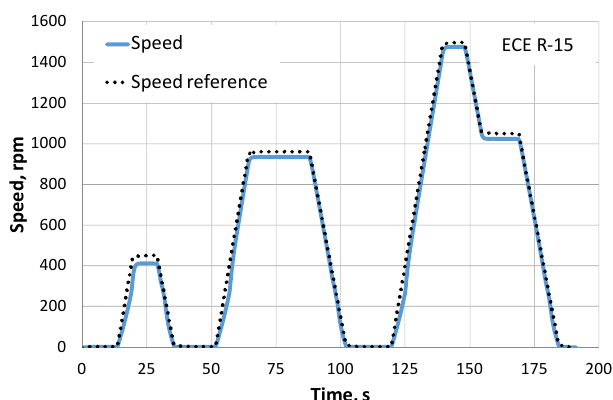
Fig. 1. Speed profile of ECE-15R driving cycle applied to the experimental setup.